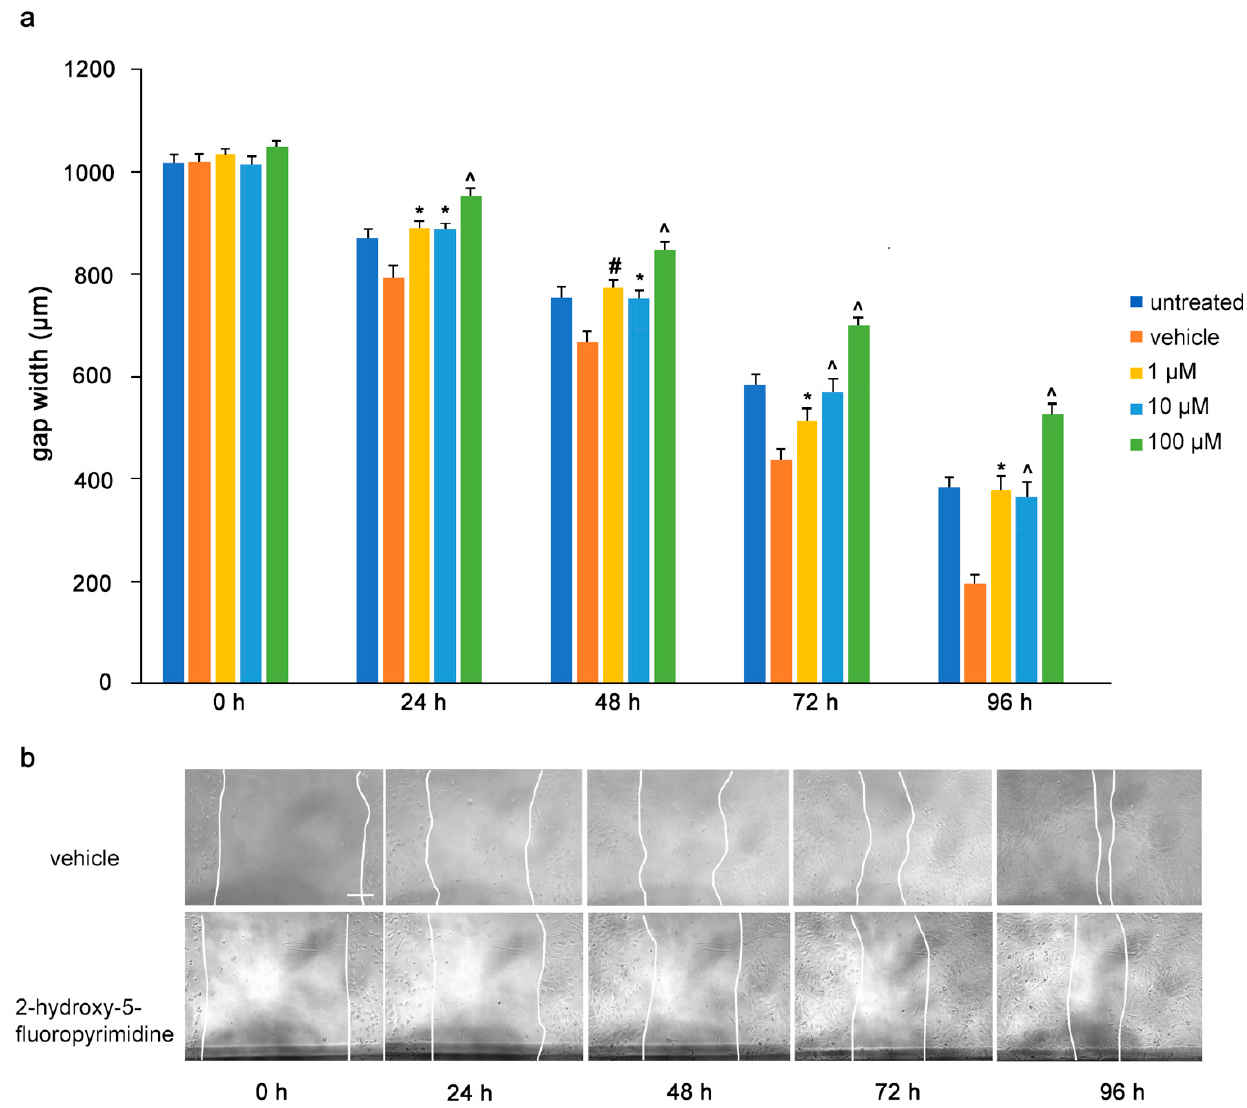
Figure 4. 2-Hydroxy-5-fluoropyrimidine inhibits migration of U251 cells. U251 cells were seeded in 96-well plates. After 24 h, monolayers were scratched, immediately imaged, and then treated with different concentrations of 2-hydroxy-5-fluoropyrimidine (1, 10 and 100 μ M). Cells were imaged every 24 h up to 96 h. ( a ) Graph represents the gap width ( μ m) of untreated cells and cells treated with vehicle or 2-hydroxy-5-fluoropyramidine. Two images were taken per well and values for each condition were averaged. Error bars show mean + SEM from 5 independent experiments. * p < 0.05, # p < 0.01, ^ p < 0.001 as determined by one-way ANOVA with Tukey’s post hoc test. ( b ) Representa- tive images of 100 μ M 2-hydroxy-5-fluoropyrimidine-treated and vehicle-treated cells. Scale bar for all images, 200 μ m in panel vehicle, 0 h.